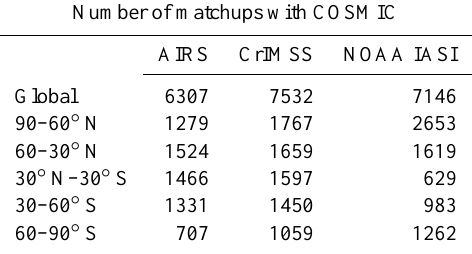
Table 2. Number of COSMIC matchups with AIRS, CrIMSS, and NOAA IASI for May 2012 selected latitude zones where quality controlled data were